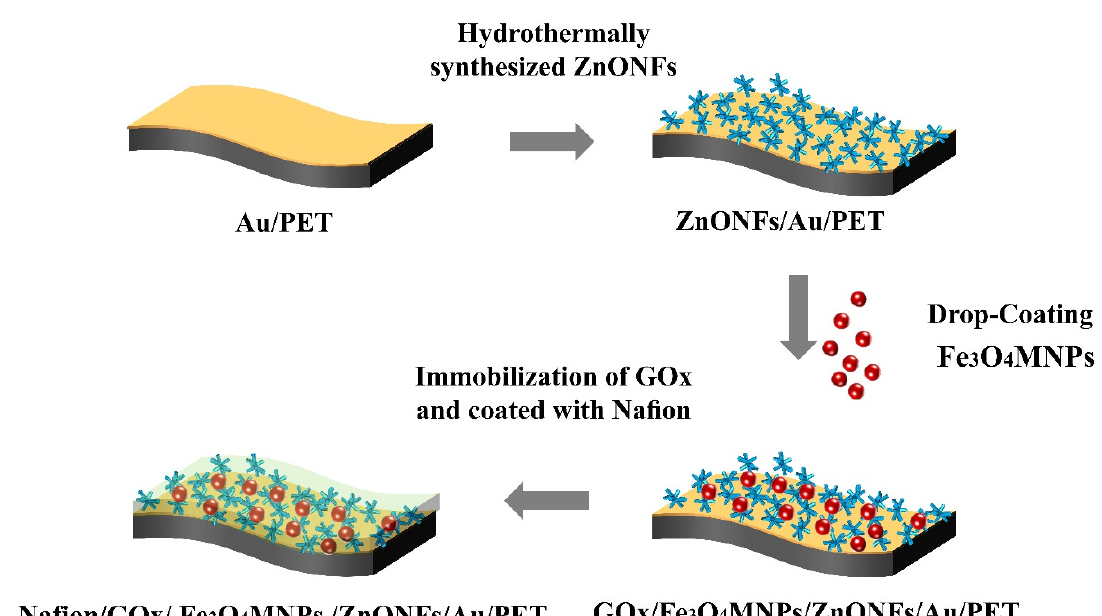
Figure 1. The fabrication process of the Nafion/GOx/Fe 3 O 4 MNPs/ZnONFs/Au/PET electrode.